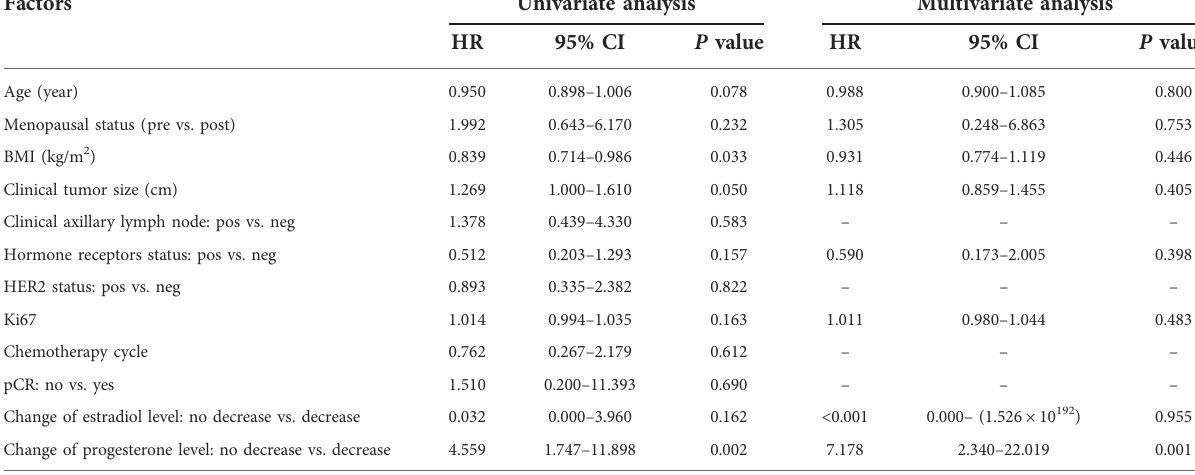
TABLE 7 Univariate and multivariate analysis for RFS in the follow-up subgroup of 91 patients.